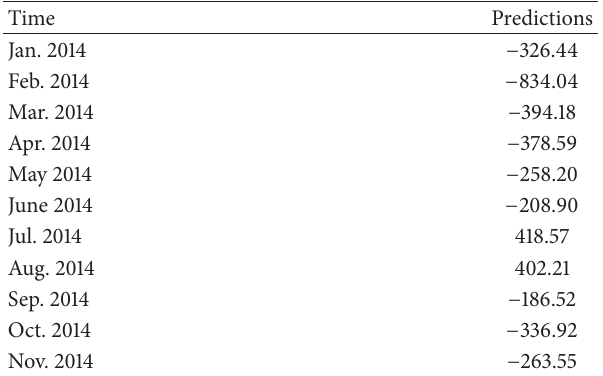
Table 5: Forecasting of {𝐶} .